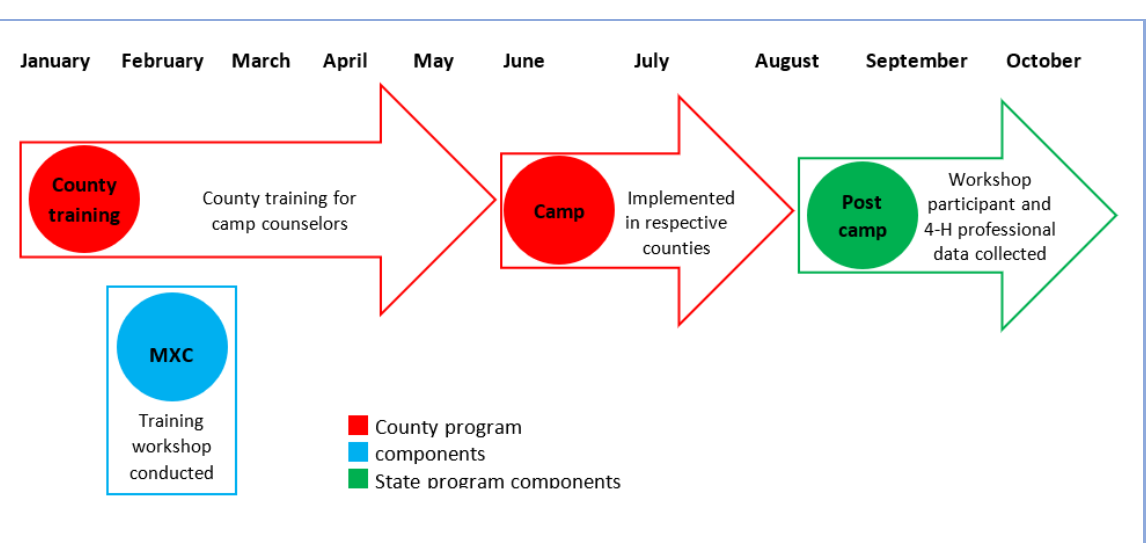
Figure 1. Program and Study